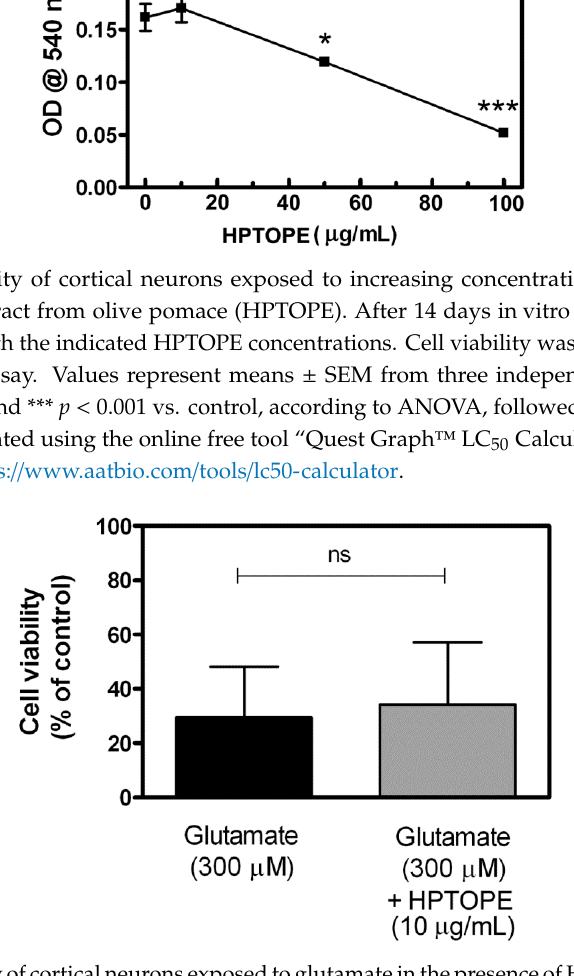
Figure 2. Cell viability of cortical neurons exposed to glutamate in the presence of HPTOPE. After 14 DIV, neurons were treated for 24 h with the indicated stimuli. Cell viability was evaluated by NRU assay. Values represent means ± SEM from nine independent experiments in triplicate. ns, not statistically significant, according to t